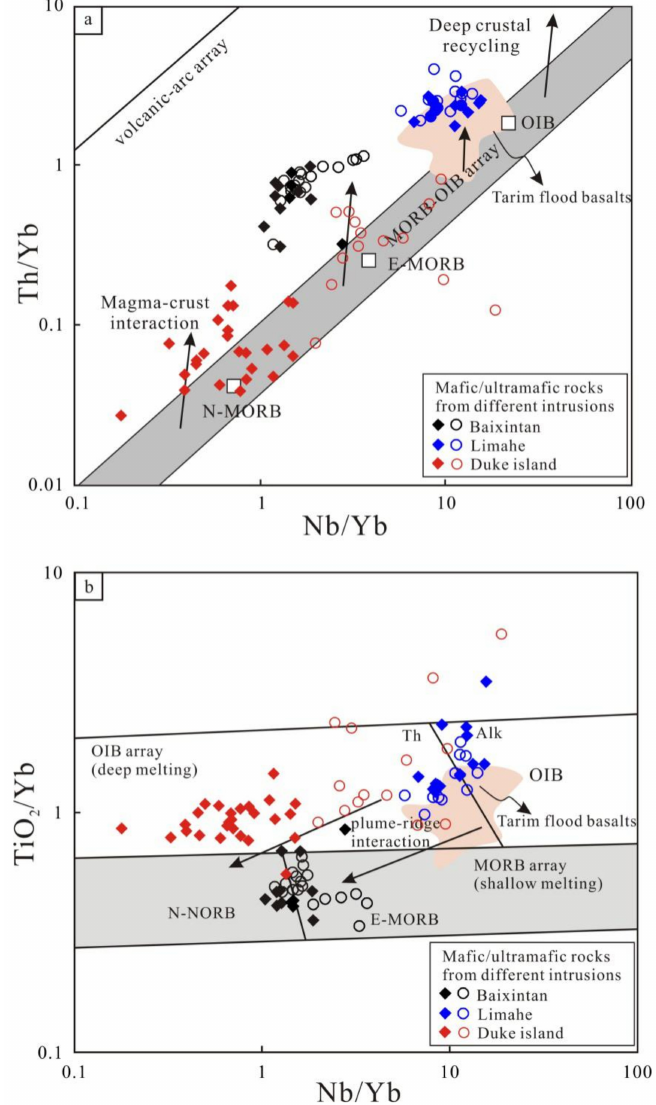
Figure 16. Nb/Yb-Th/Yb diagram ( a ) and Nb/Yb-TiO 2 /Yb diagram ( b ) for the Baixintan, Limahe, and Duke Island intrusions (after [140]). Data sources are the same as in Figure